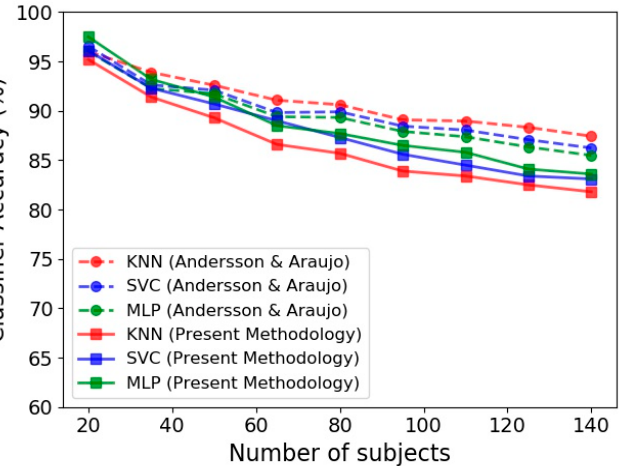
Figure 7. Accuracy of gender identification for three classifiers, namely KNN, SVC and MLP based on the Kinect gait biometry dataset, compared for our methodology (solid lines) with respect to that of Andersson and Araujo [29] (dashed lines).